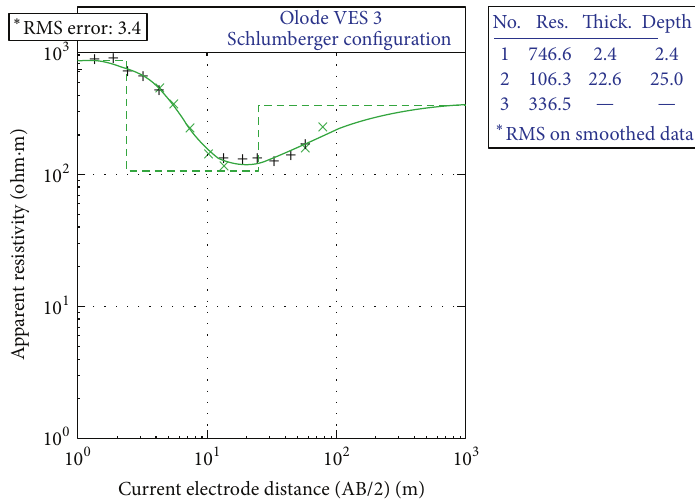
Figure 15: Sounding curve of VES 3.